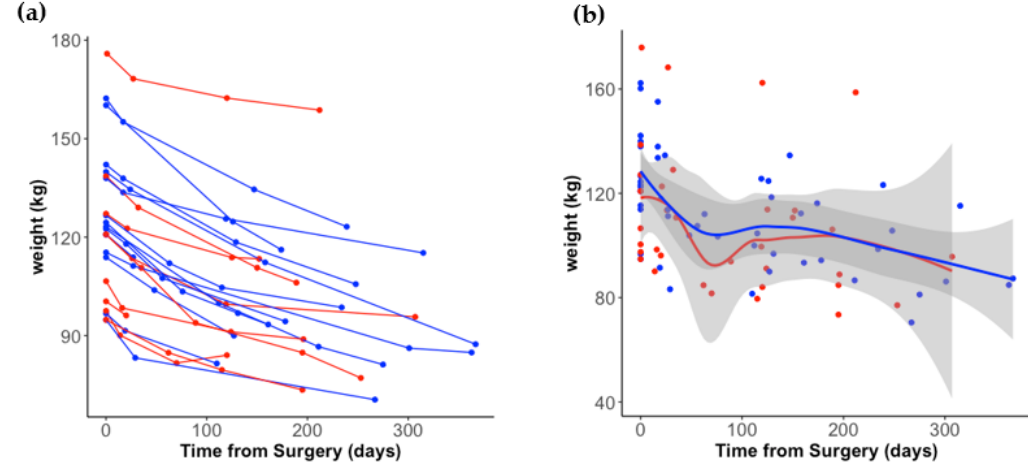
1 Represents Fisher’s exact test for categorical variables. 2 Represents unpaired t -test for continuous variables.